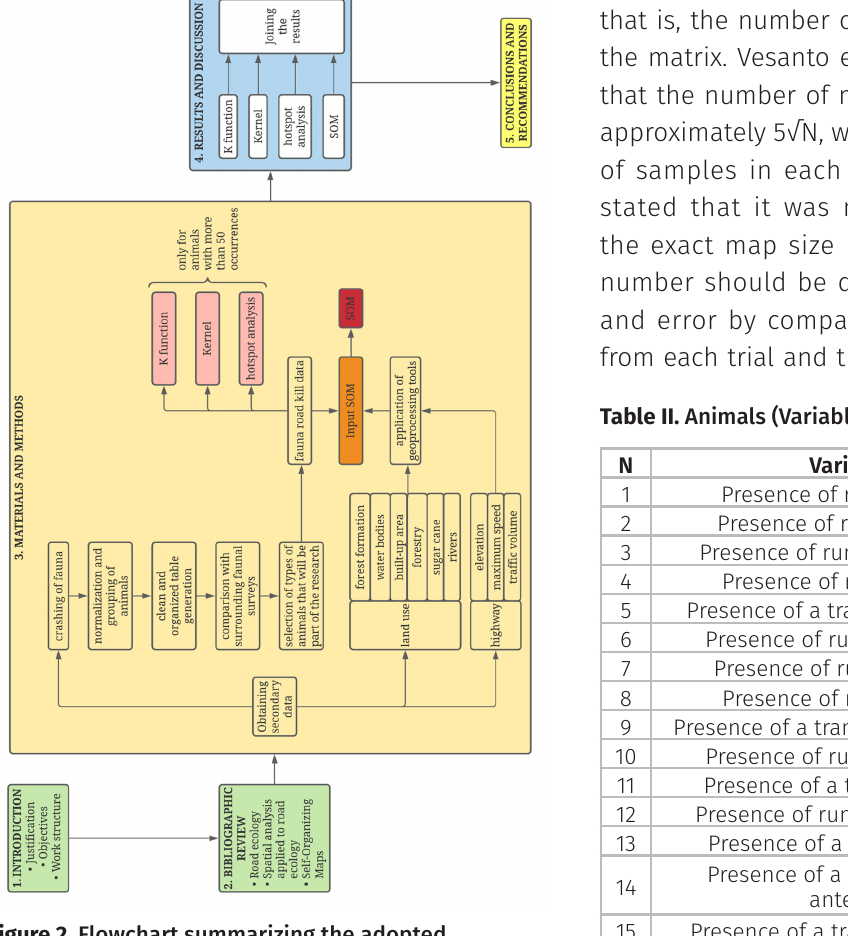
Figure 2. Flowchart summarizing the adopted